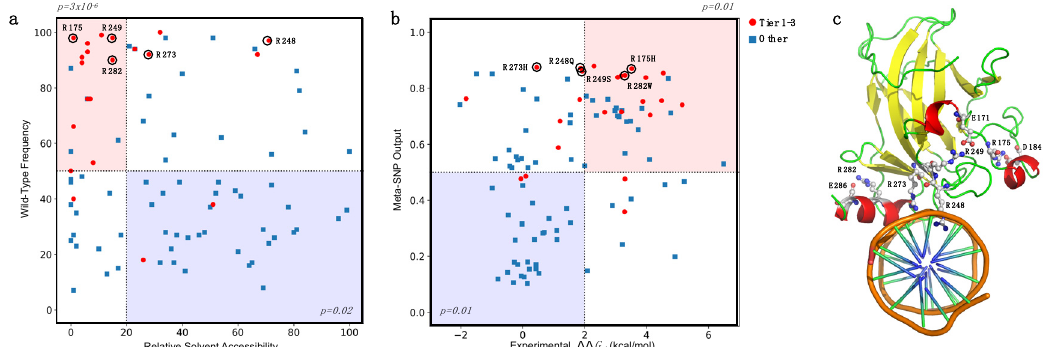
Figure 7. Enrichment and depletion of putative cancer-driving variants (Tier 1–3) in different subgroups. ( a ) Enrichment of Tier 1–3 variants in mutated sites with Relative Solvent Accessibility ≤ 20% and frequency of the wild-type residue > 50% (light red). ( b ) Enrichment of Tier 1–3 variants in the subset of mutants with experimental ΔΔ G f > 2.0 kcal/mol and Meta-SNP output >0.5 (light red). In both cases, the opposite regions (light blue) are depleted of Tier 1–3 variants. In ( a , b ), the hotspot mutants R175, R248, R249, R273, and R282 are highlighted with black circles. ( c ) Hotspot sites in the p53 structure in interaction with DNA (PDB:1TUP). Residues R248 and R273 interact with DNA. Residues R175, R249, and R282 are likely to stabilize the protein structure by forming salt bridge interactions with D162, E171, and E286, respectively. If we considered the subset of highly destabilizing ( ∆∆ G f > 2.0 kcal/mol) and pre- dicted pathogenic (Meta-SNP output > 0.5) variants, we found an enrichment in Tier